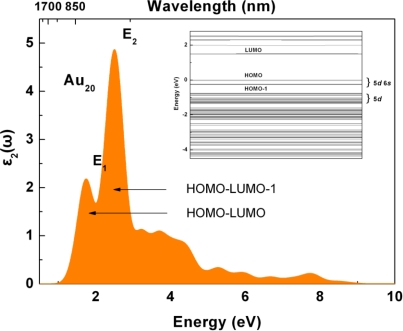
The imaginary part of dielectric function ɛ2(ω) of Au20 clusters.